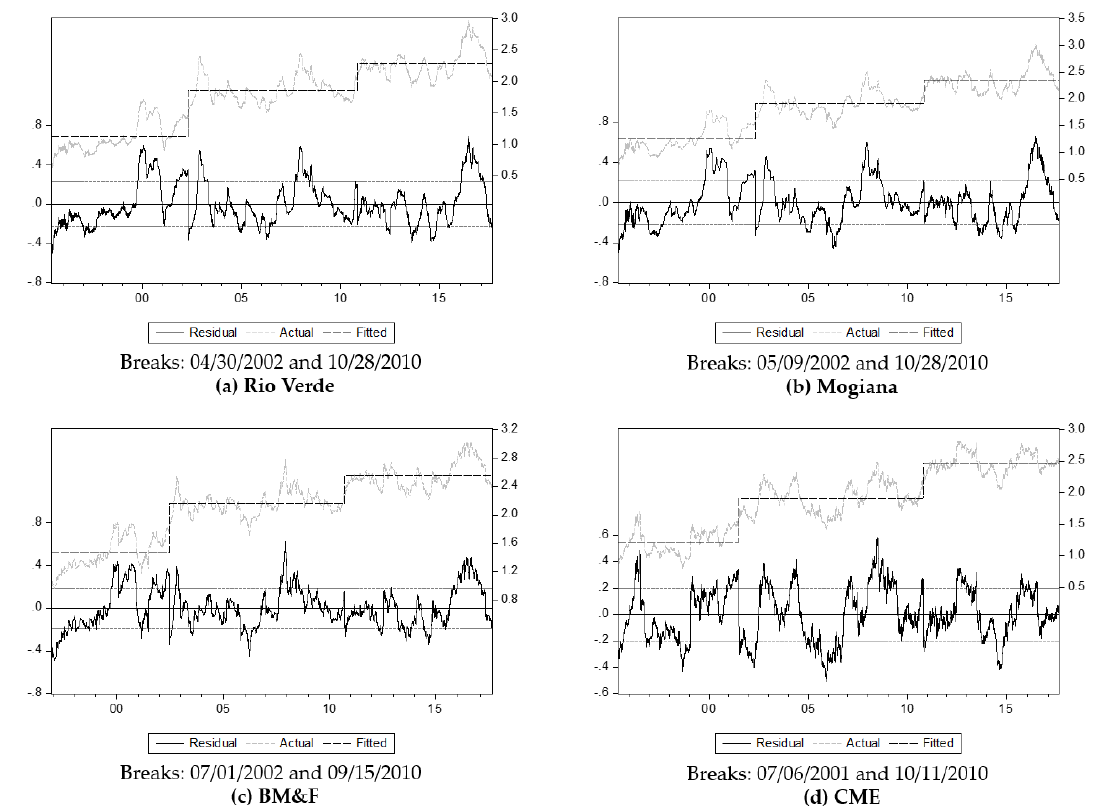
Figure A1. Estimated break dates for daily corn prices during 1995–2017.